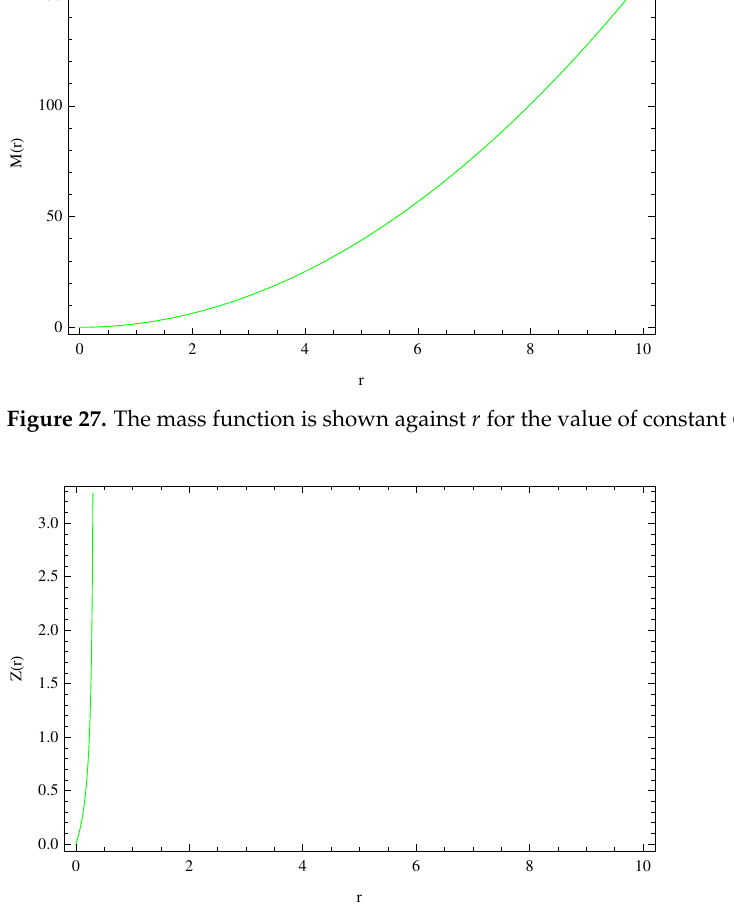
Figure 28. The redshift function is shown against r for the value of constant C 3 = 2. We find that both mass function and and redshift function are positive. As per latest observations, galaxies and the objects producing gamma ray bursts have the highest known redshifts. The most reliable redshifts are confirmed from spectroscopic data, and the highest spectroscopic redshift of a galaxy is that of GN − z 11 [46], with a redshift of Z = 11.1, which corresponds to 400 million years after the Big